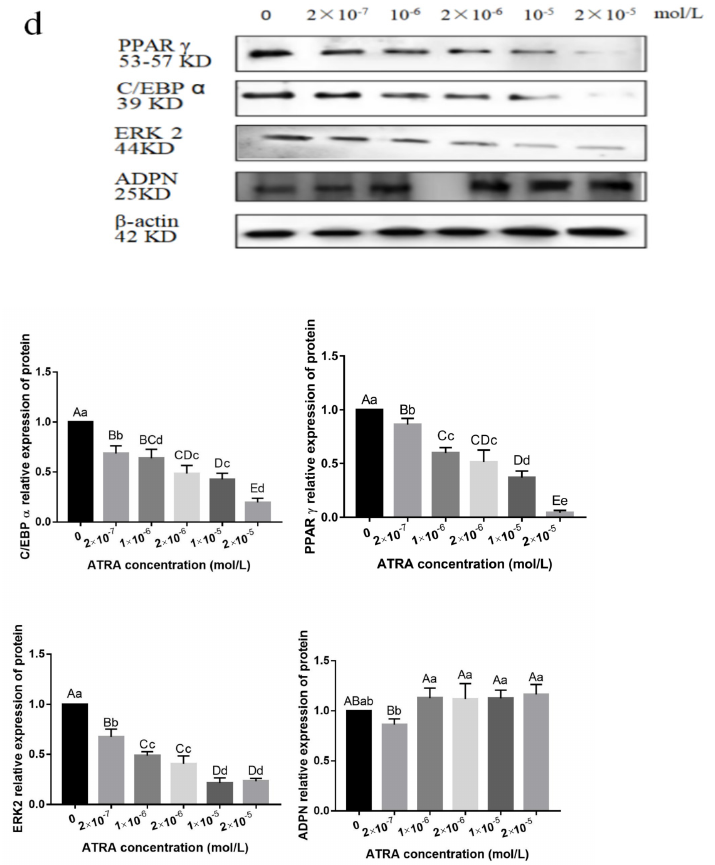
Figure 2. Effect of ATRA on the differentiation of preadipocytes from Yanbian yellow cattle. ( a ) Oil Red O staining of pre-adipocytes (200×) after treatment with different concentrations of ATRA after the ninth day of differentiation. ( b ) The lipid content of differentiated cells was quantified by extracting Oil Red O with isopropanol and measuring its absorption at 520 nm. ( c , d ) Quantitative reverse-transcription polymerase chain reaction (qRT-PCR) and western blotting were used to determine the levels of PPAR γ , C/EBP α , ERK2, ADPN mRNA and ( d ) protein in ATRA treatment groups. Different lowercase letters in the figure indicate significant differences compared with the control group, p < 0.05. Different capital letters indicate highly significant differences compared with the control group, p < 0.01. Full Western Blot Figure S1 and Table S1 are provided in the supplemen- tary file.